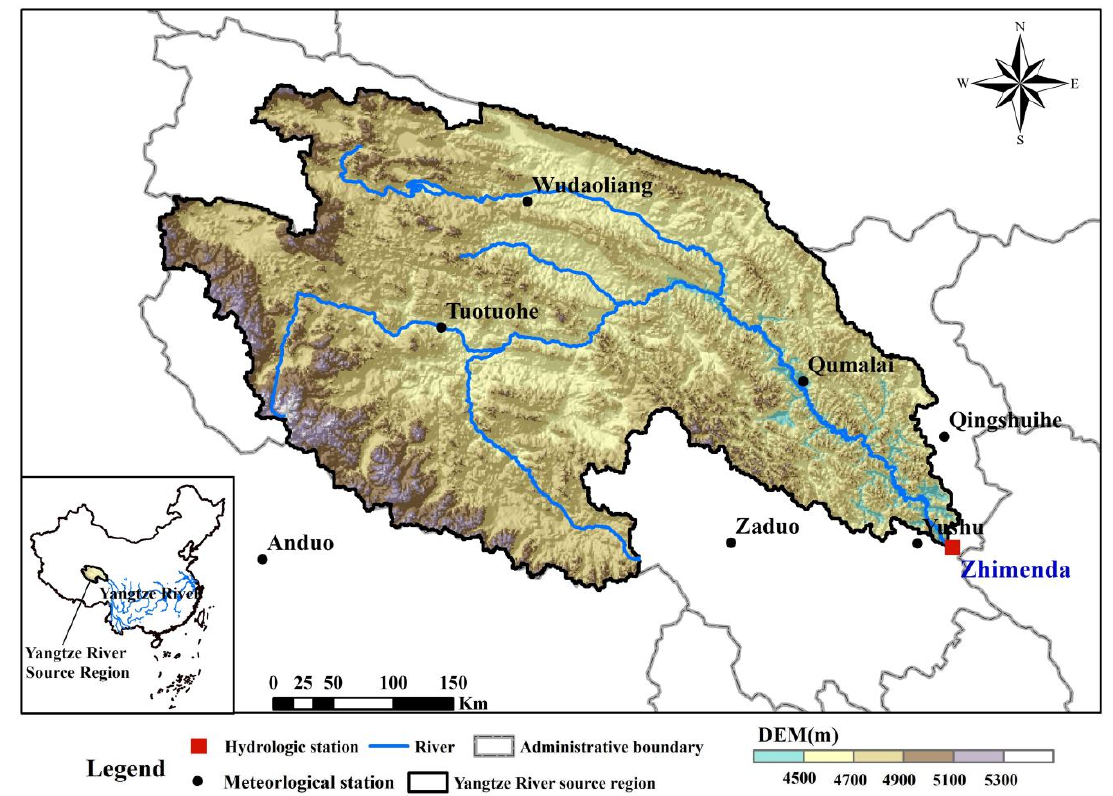
Figure 1. Topographical map of the headwaters area of the Yangtze River.